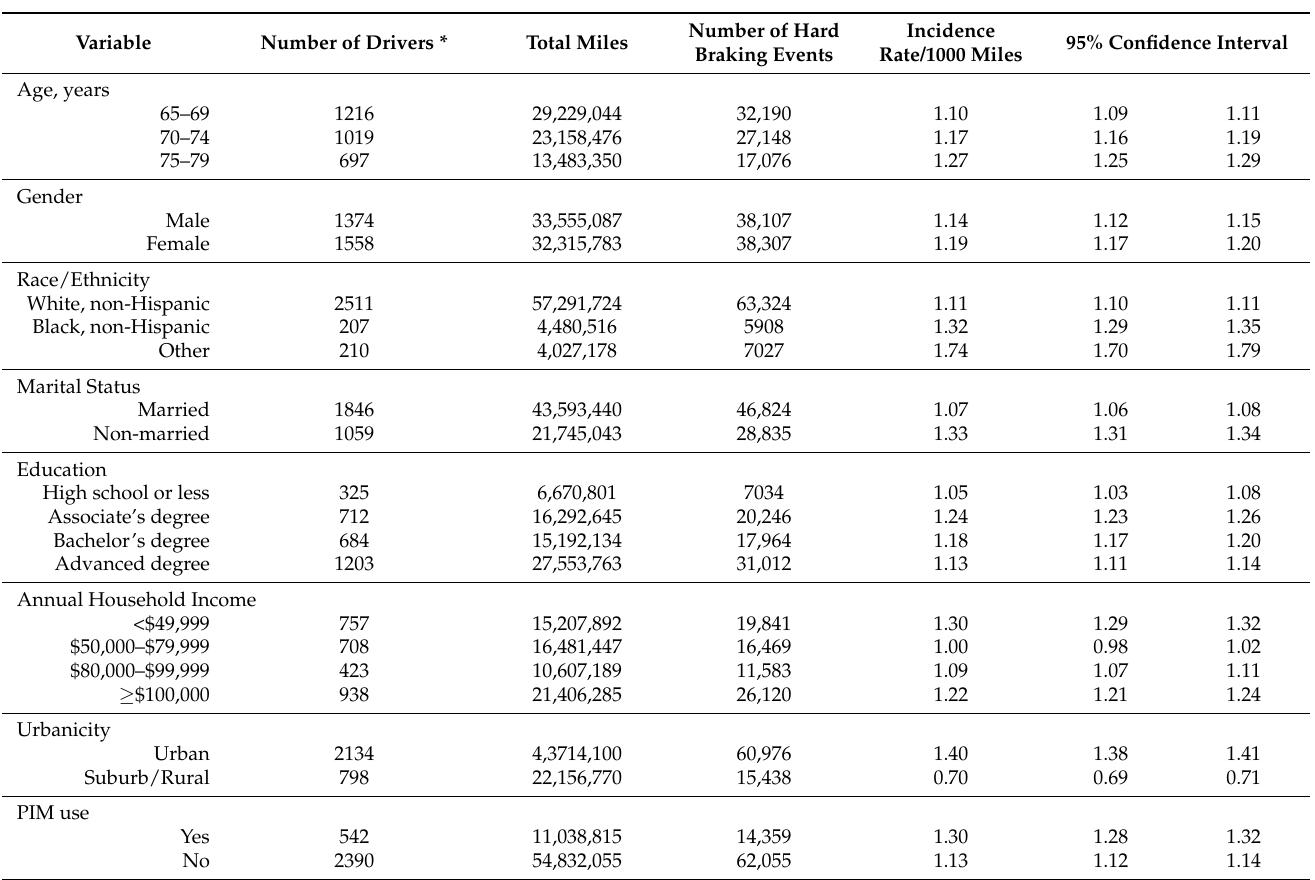
Table 1. Incidence rates of hard braking events per 1000 miles by demographic characteristics, the Longitudinal Research on Aging Drivers (LongROAD)